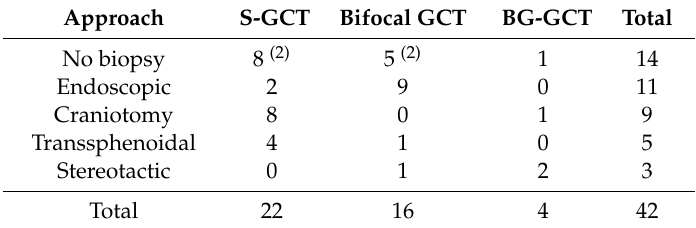
The number in parenthesis (x) represents the number of patients undergoing second-look surgery after initial treatment with radiation or